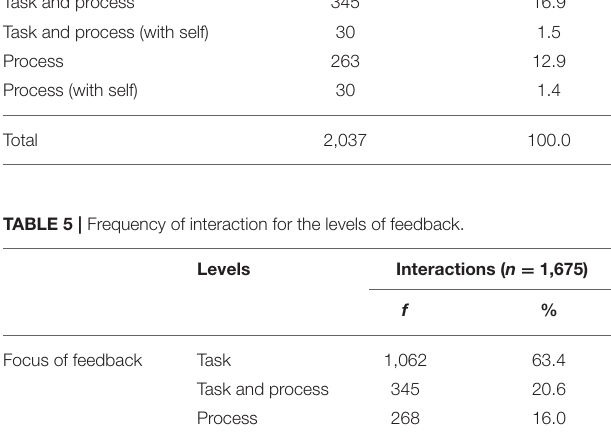
categories) × Type of Interaction (2